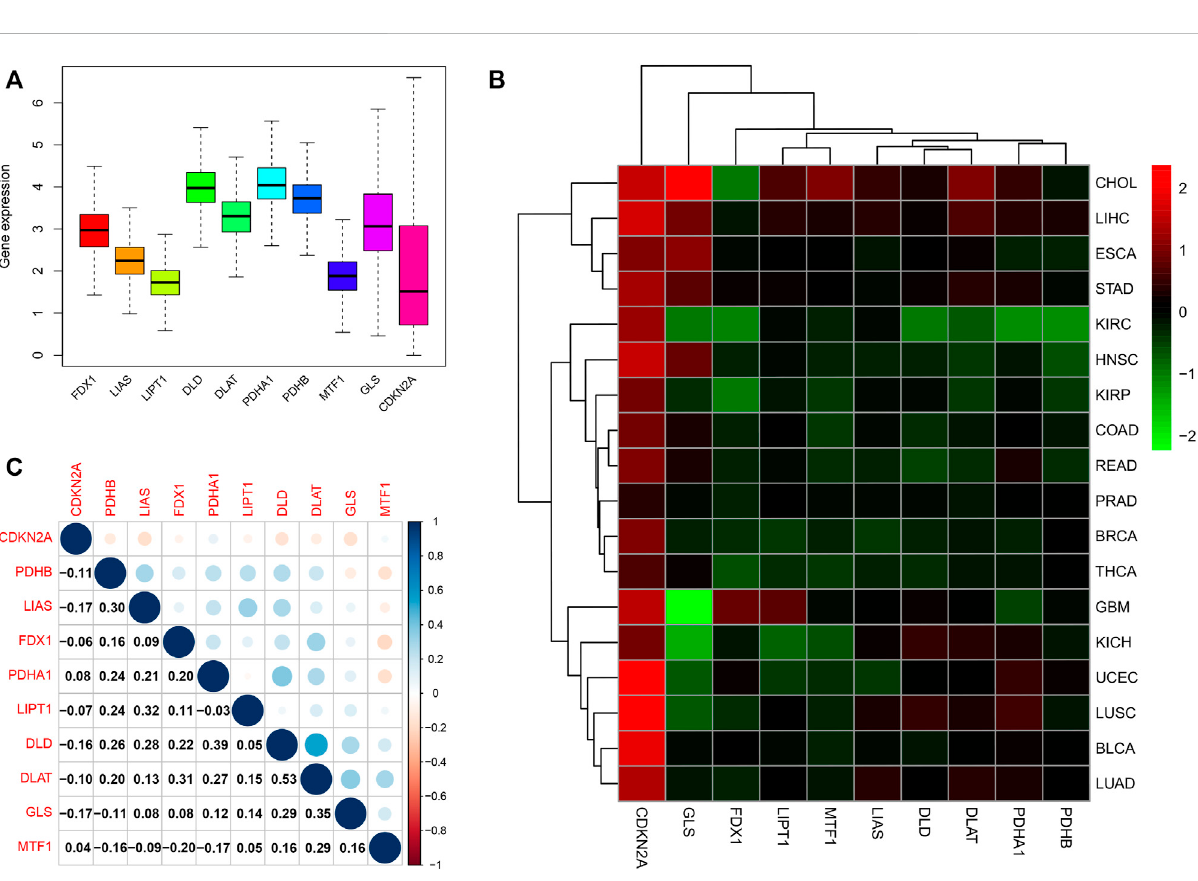
FIGURE 2 Differential expression and correlation analysis of 10 cuproptosis-associated genes in various cancer types. (A) Different levels of cuproptosis- associated genes in 33 cancers. Different colors in the bar chart represent different genes. The Y-axis in boxplot means the relative gene expression level in pan-cancer. (B) The differential expression of cuproptosis-associated genes in 18 cancers. The red boxes indicate high expression, and the green boxes indicate lowexpression. (C) Correlation analysis ofcuproptosis-associated genes. Blueand reddots indicate positive andnegative correlations,